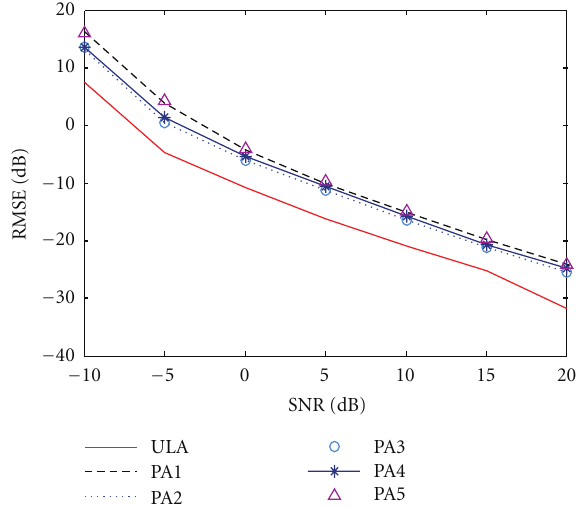
Figure 2: The MUSIC spectrum for the ULA and di ff erent PA configurations, DOAs ( − 85 ◦ , − 10 ◦ , 10 ◦ , 85 ◦ ).